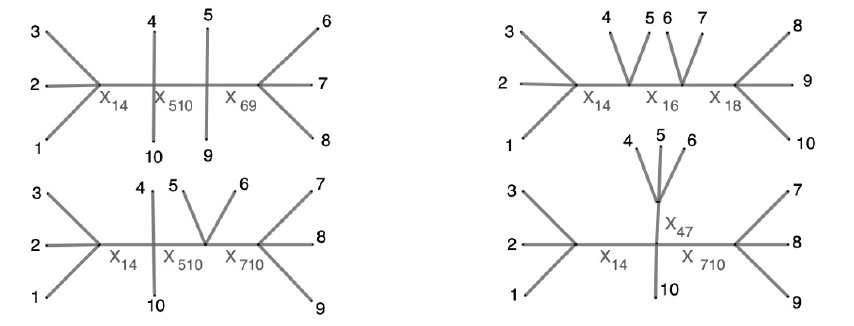
Figure 16 . The primitive quartic graphs (in clockwise order) with corresponding Stokes polytopes being Cube, Associahedron (2-4), Lucas and Mixed Classes (6 and